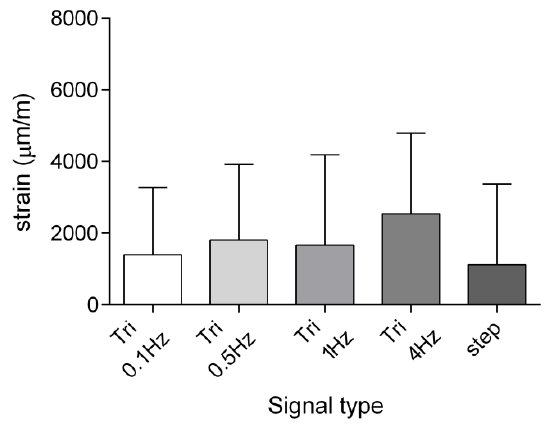
Figure 8. Means ± SDs of the transverse strains measured by DIC . n = 5.